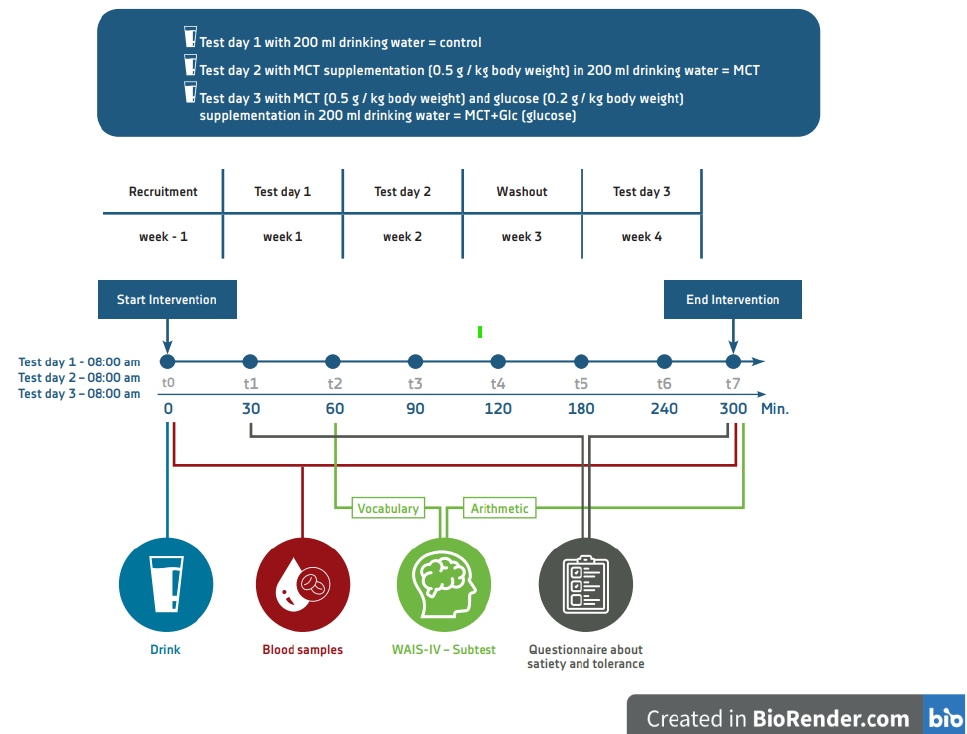
Figure 2. Overview of the study design.